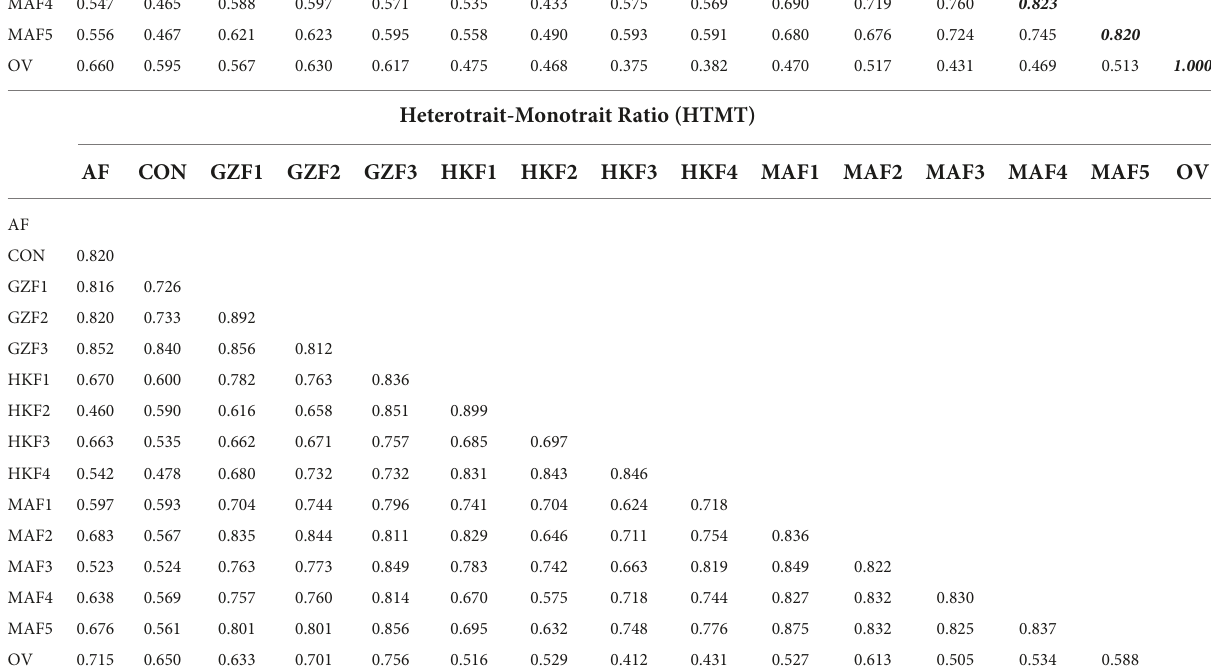
TABLE 4 Discriminate validity for first-order constructs.